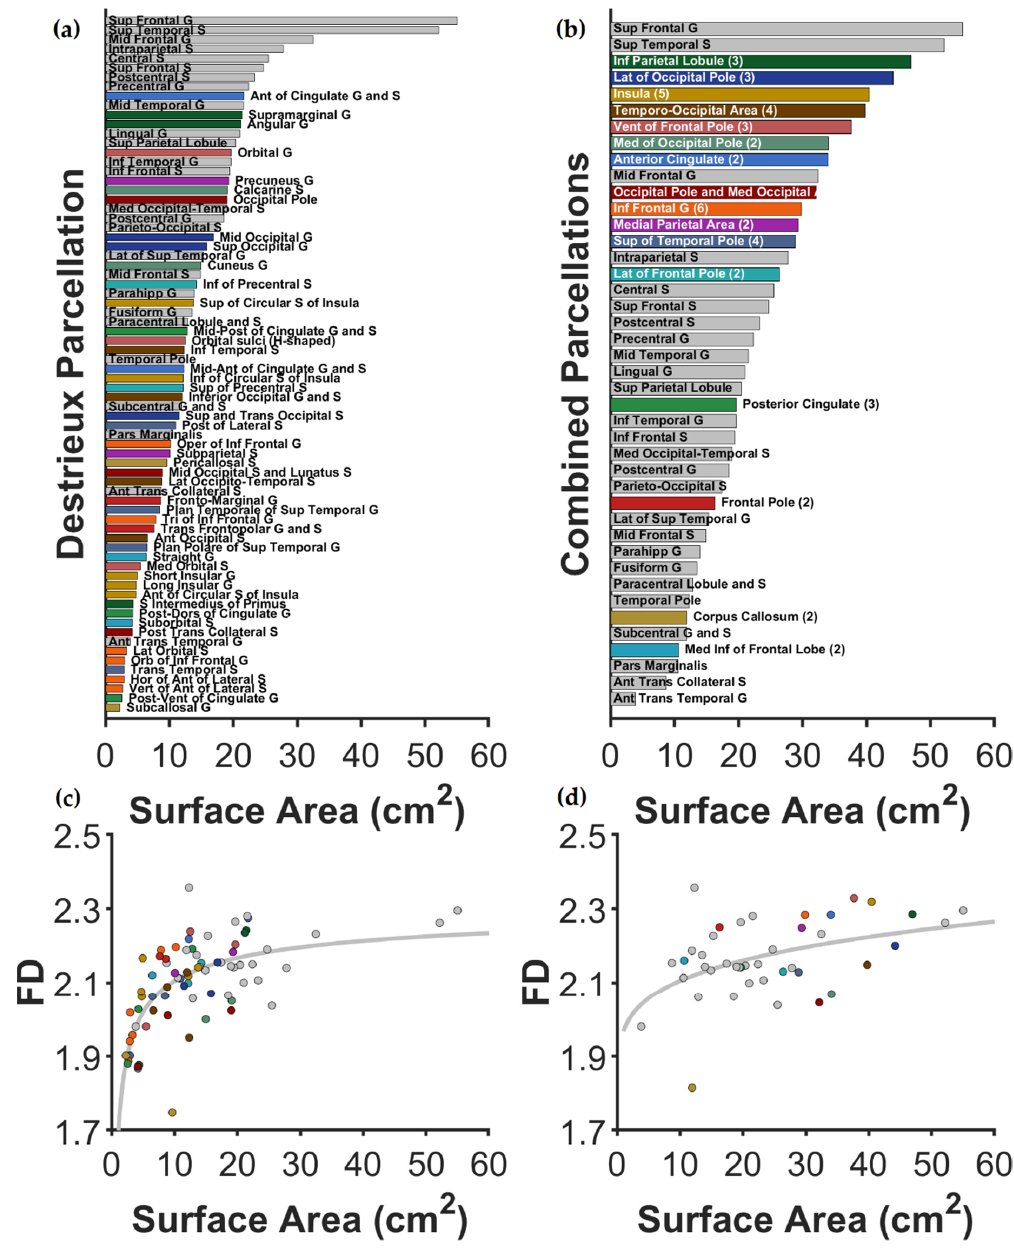
Figure 2. Mean surface area for all parcellation regions using the Destrieux atlas. Figures ( a , c ) show the surface area for parcellations in the original Destrieux atlas; Figures ( b , d ) show areas for combined regions—where the original regions were considered too small for reliable FD calculations. Regions maintained (not combined) in all plots are shown in gray. Regions that were combined to form larger regions are shown in distinct colors, matched between the panels and in Figure 3C. For Figure ( b ), after each combined region’s name, the number of Destrieux regions combined is included in parentheses. Figures ( c , d ) show the relationship between surface area and FD (across all participants), showing that FD becomes increasingly distinct from size for larger regions and that the combined regions increased this property. As above, Figure c corresponds to the original Destrieux atlas, whereas figure d uses the recombined